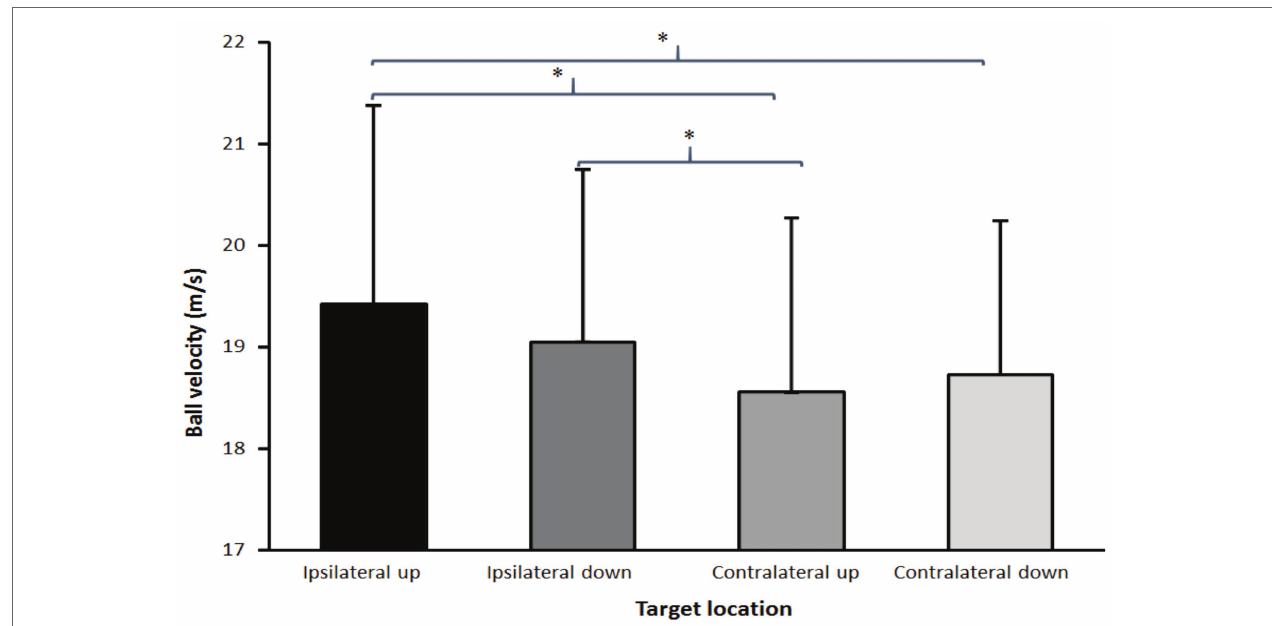
FIGURE 3 | Average ball velocity for each target location in the goal from each target of the goal. * indicates a significant difference in ball velocity between these two target locations on a p < 0.05